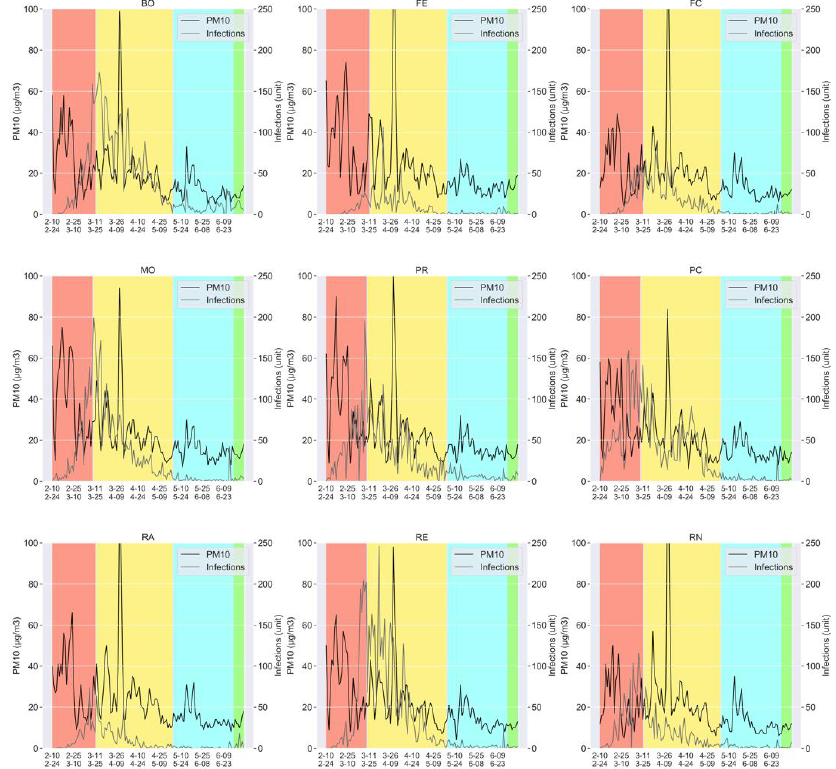
Figure 3. The dataset (II): infections, pollutant (PM 10 ), and phases.